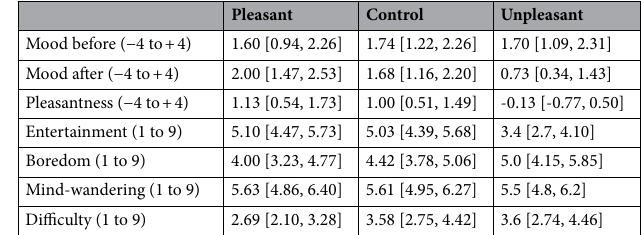
Pleasant Control Unpleasant Mood before (−4 to +